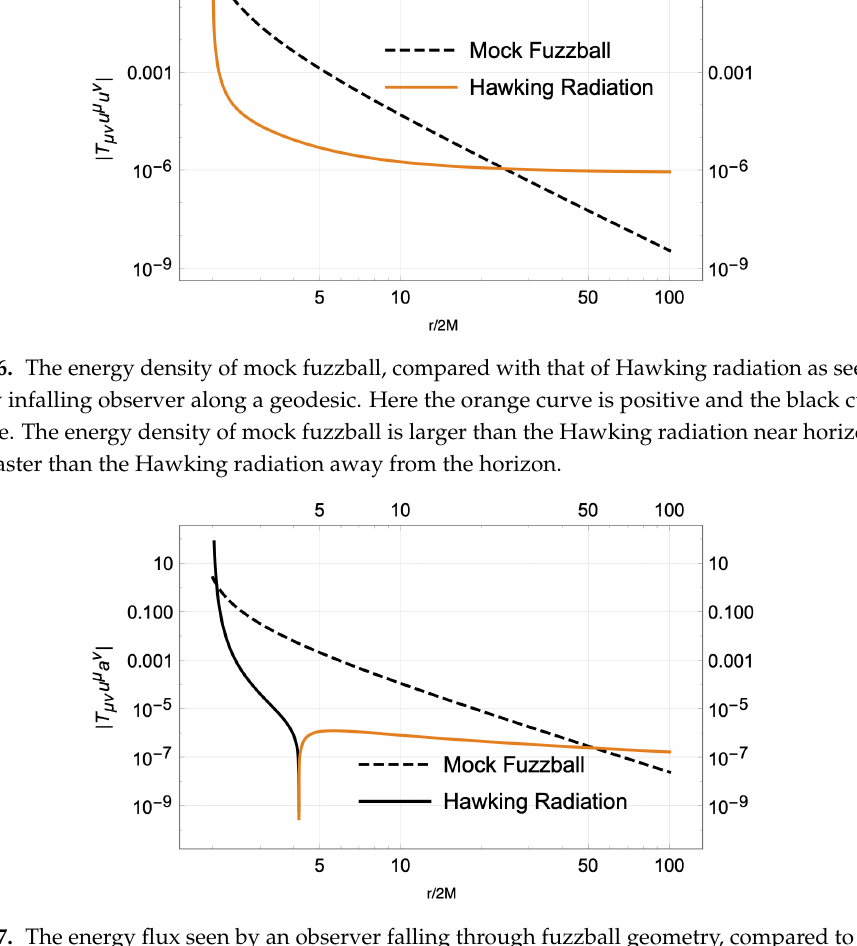
Figure 7. The energy flux seen by an observer falling through fuzzball geometry, compared to that of Hawking radiation. Here the orange curve is positive, while the black curves are negative. The flux of mock fuzzball is larger than the Hawking radiation near horizon and drops faster than the Hawking radiation away from the